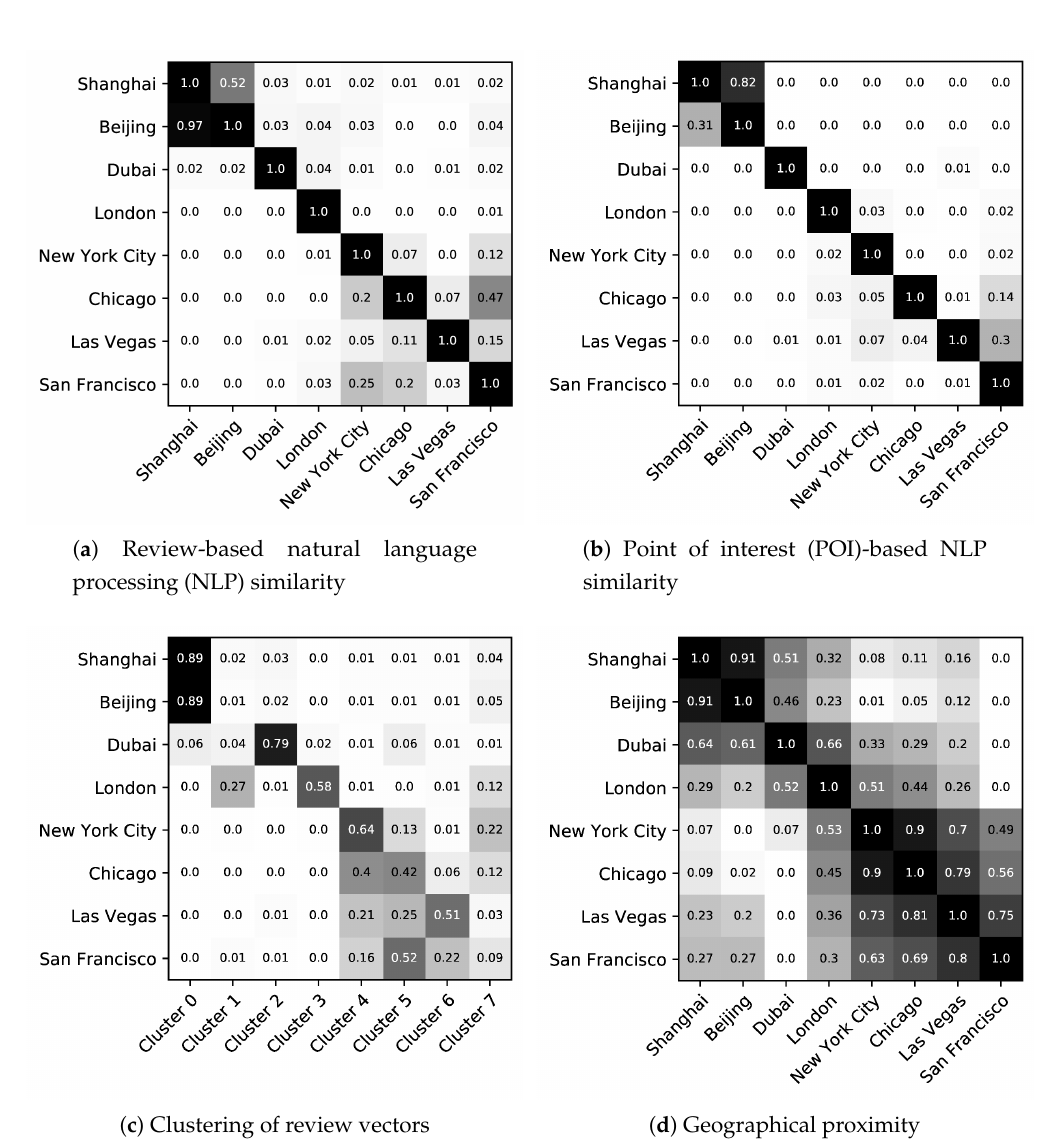
Figure 3. City similarity heat